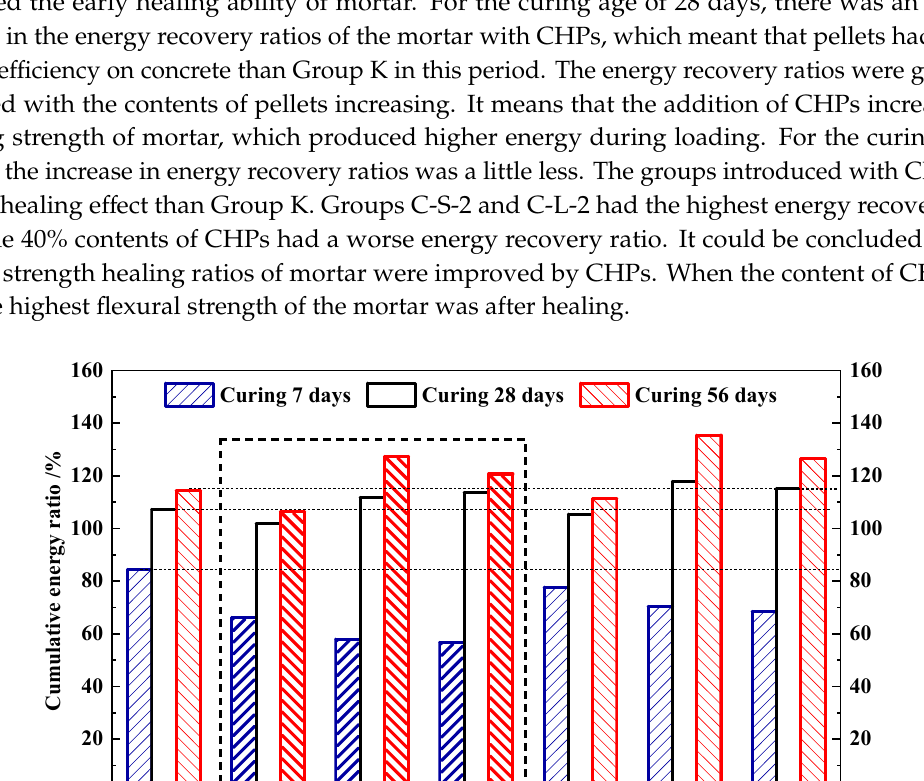
Figure 19. The increment of damage parameter at different curing ages.